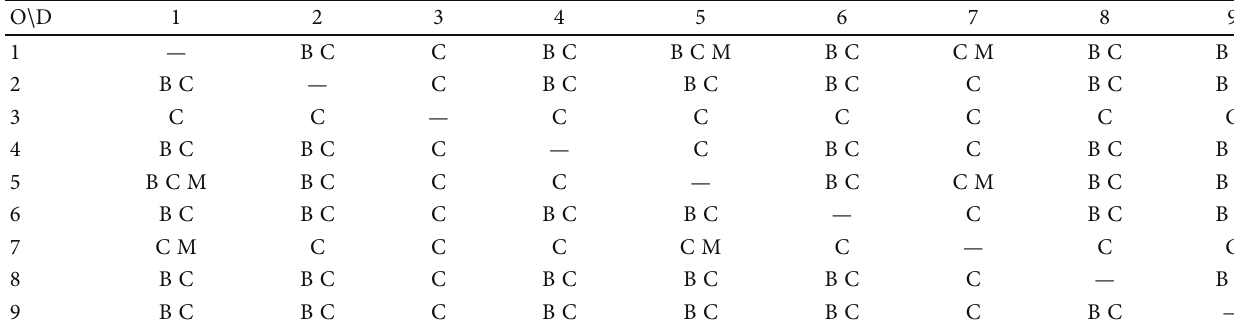
Table 3: Mode choice options between OD